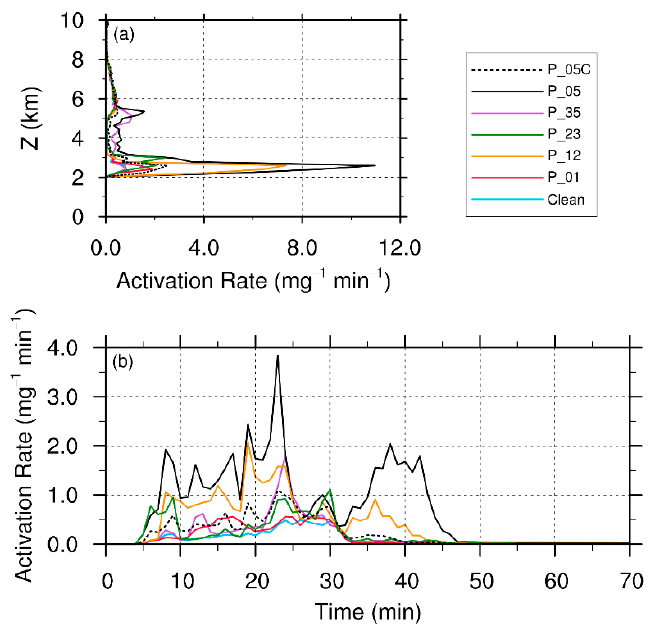
Figure A2. The ( a ) vertical profiles and ( b ) time series of CCN activation rate in all the simulations. Similar to Figure 4 but the P_05C simulation is included in.